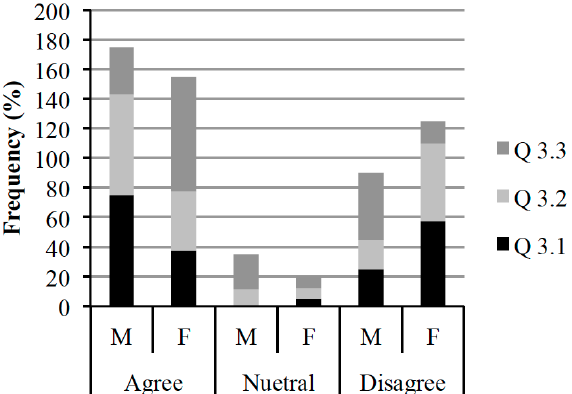
Fig. 4. Male and female students’ responses to the questions of Section 3 in Questionnaire A